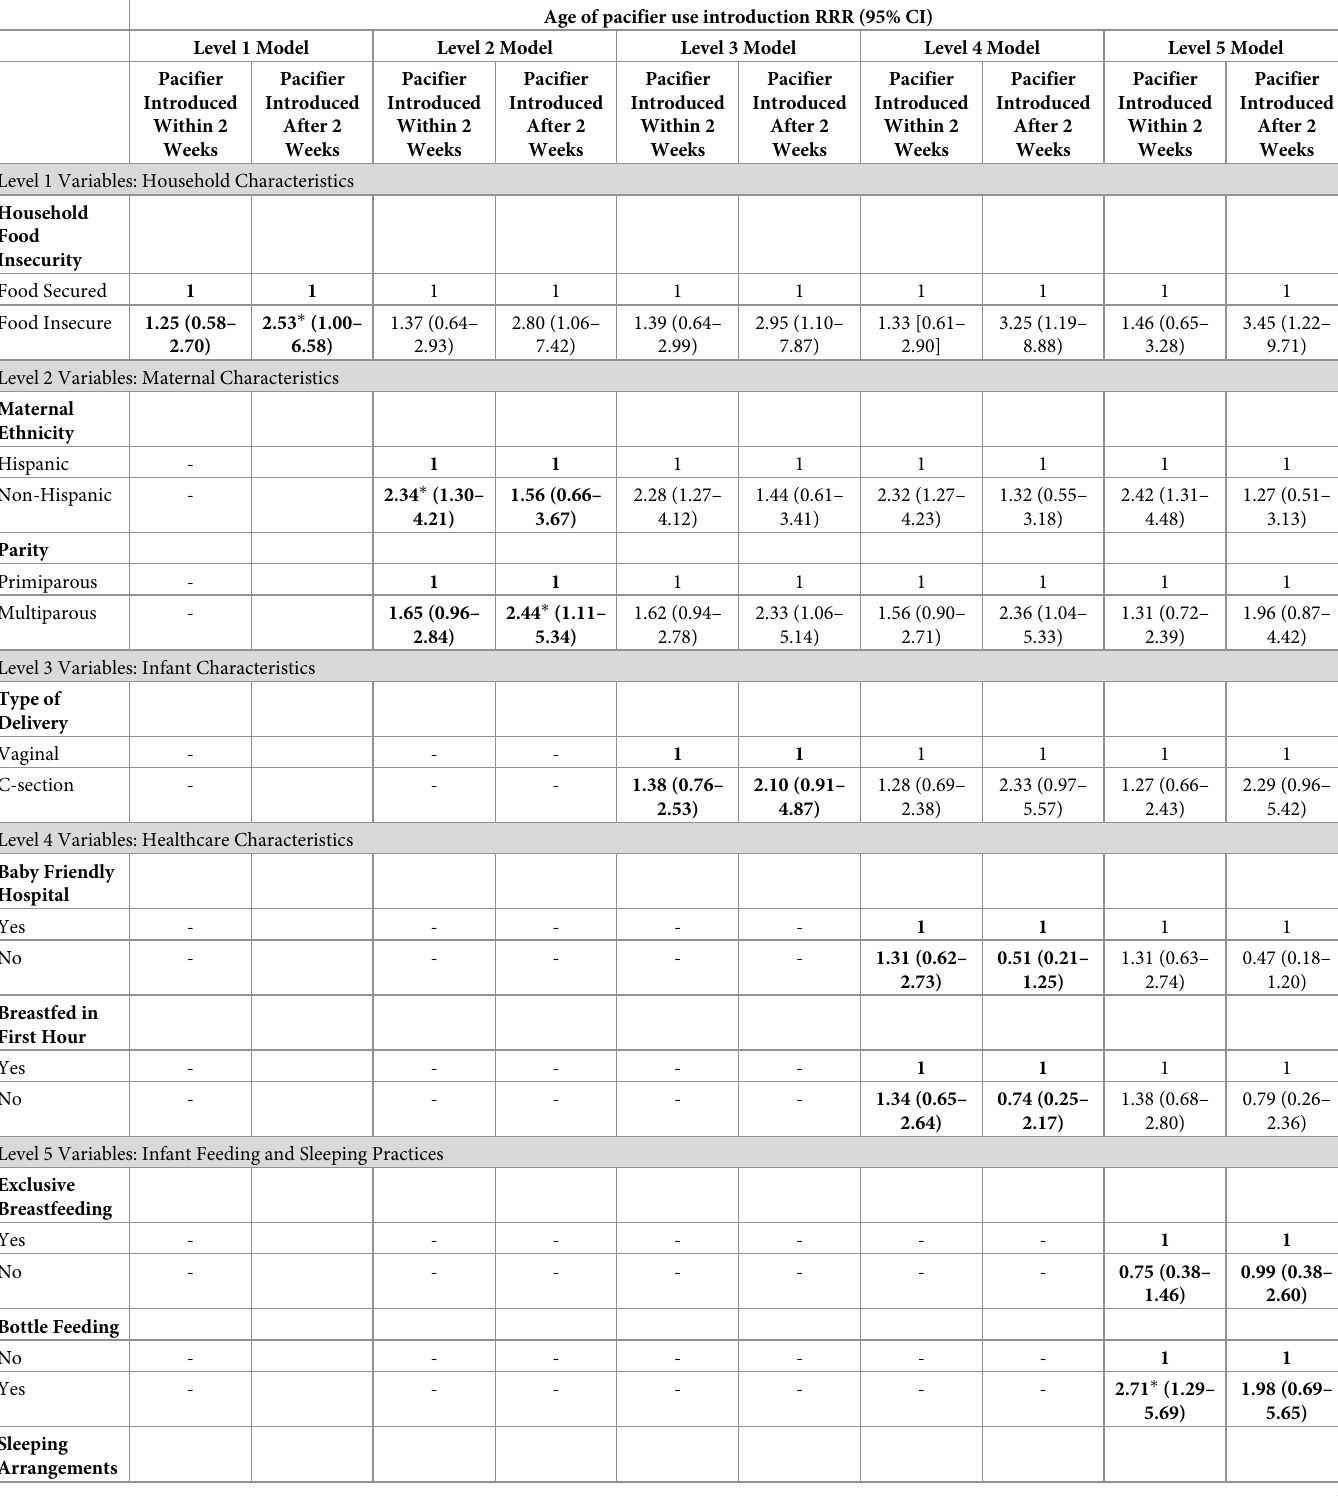
Table 5. Multinomial logistic regression on the association between age of pacifier use introduction and household, maternal, infant, and health care characteristics as well as infant feeding and sleeping practices, 2021. A value of “1” across rows indicates the comparison group in the model categorical